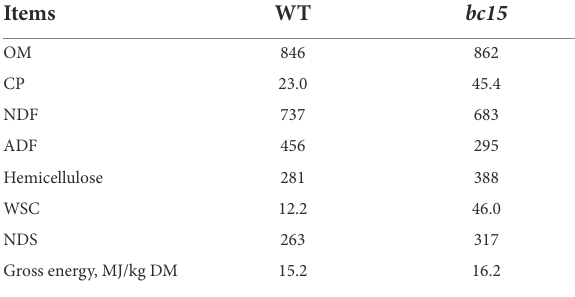
TABLE 2 Chemical composition of wild-type (WT) and brittle culm 15 ( bc15 ) mutant rice straws (expressed in g/kg of dry matter; N = 3). Items